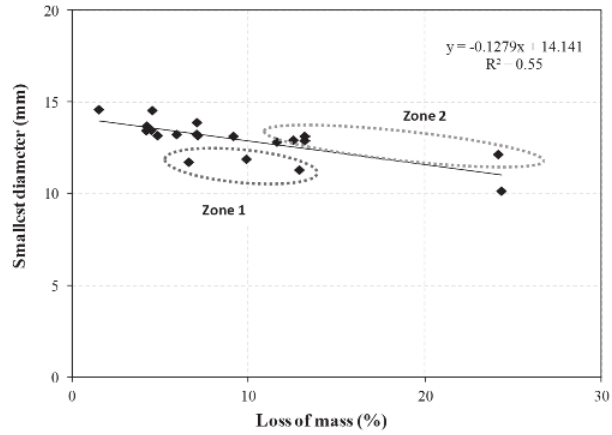
Figure 14 Ratio between smallest diameters and the loss of mass of the test specimens